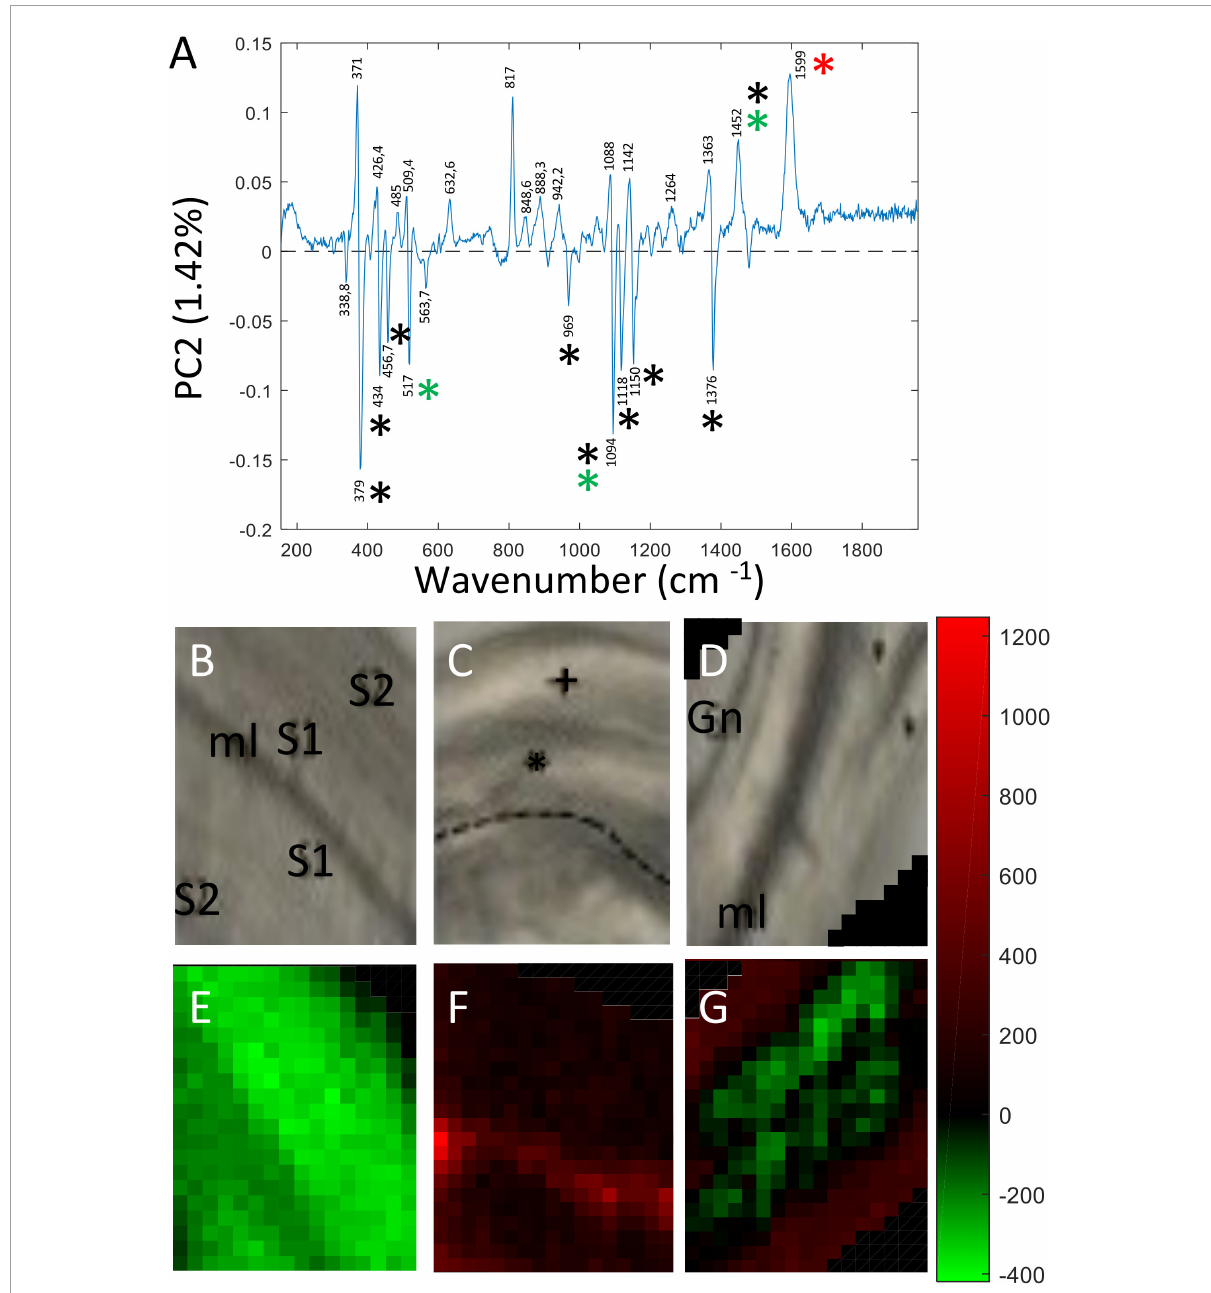
FIGURE4 PC score imaging of PC2 (1.42%). (A) Loading vector of PC2. Peaks making positive contributions concerned chemical bonds related to lignin (1,270; 1,599 cm − 1 ), cellulose/xyloglucan (1,452 cm − 1 ). Peaks making negative contributions were mainly assigned to cellulose (379; 435; 457; 1,094; 1,150; 1,376 cm − 1 ), xylan (1,118 cm − 1 ) and xyloglucan (517 cm − 1 ). Only major contributions (positive or negative) are considered. Black asterisk: cellulose, Red asterisk: lignin, Green asterisk: xylan and xyloglucan. Blue asterisk: pectin. (B,E) Bast fibers control. (C,F) Bast fibers from the pulling side. (D,G) Bast fiber from the opposite side. The 817 cm − 1 peak (positive contribution) was really ambiguous to assign to a particular polymer and was not considered as reliable.